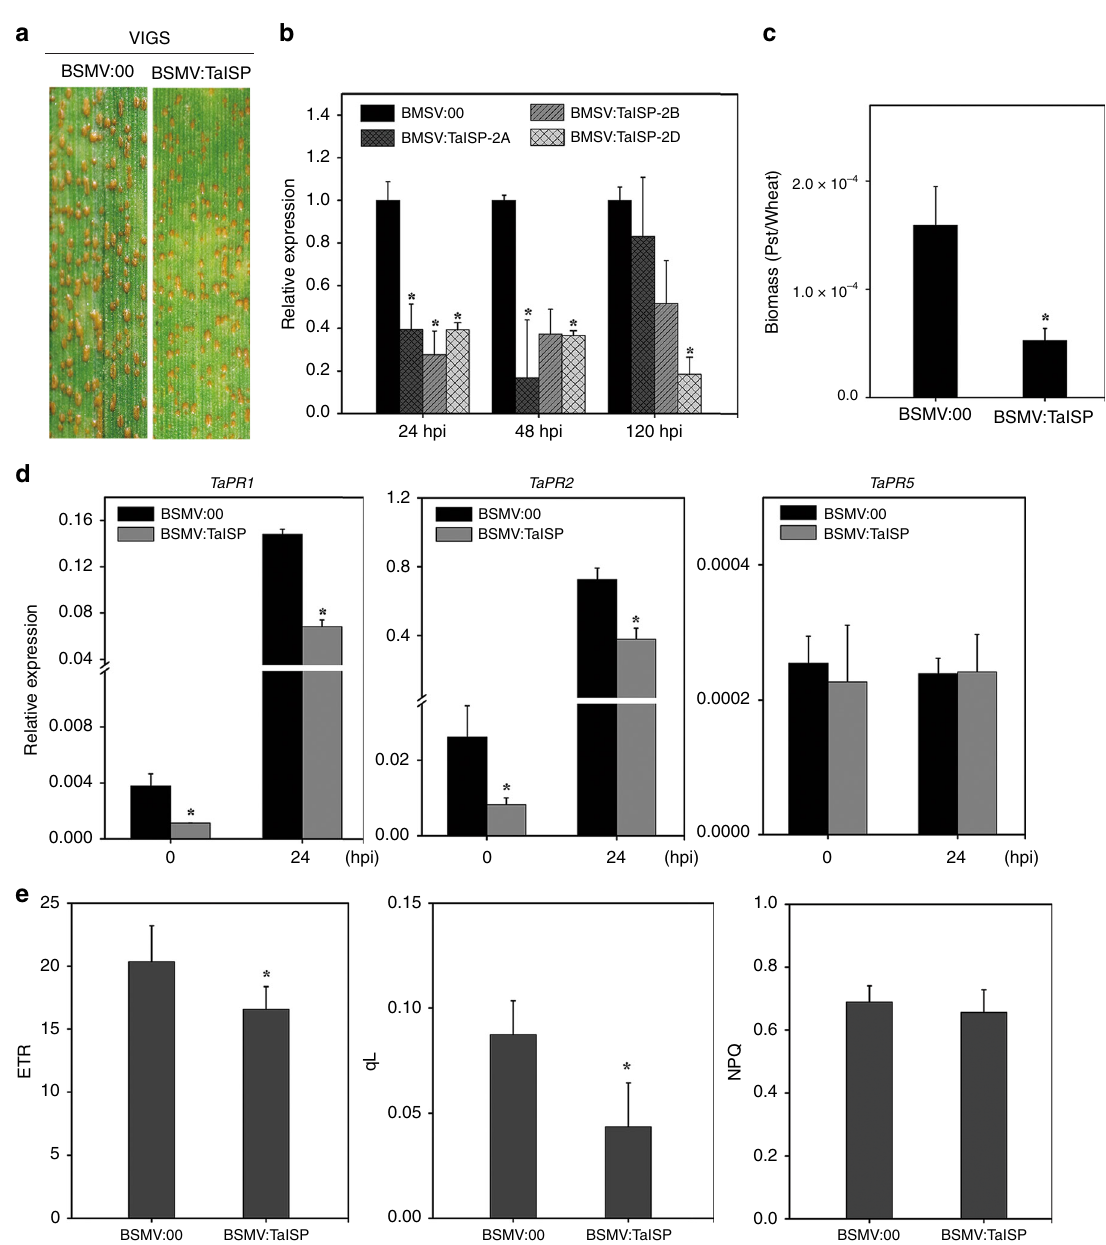
Fig. 6 Knocking down TaISP increases resistance to Pst and weakens photosynthesis. Seedlings of wheat cultivar Suwon 11 were inoculated with the empty BSMV:00 vector or recombinant BSMV:TaISP on the second leaves fi rst for 10 days and then infected with Pst CYR31 on the fourth leaves. a Pst uredinia on the fourth leaves were examined at 14 dpi. b The relative expression level of TaISP in leaves inoculated with Pst were assayed by qRT-PCR at 24, 48, and 120 hpi. c The biomass ratio ( Pst /wheat) was assayed with RNA isolated from the fourth leaves at 120 hpi. TaEF-1 α and PstEF-1 α were used to normalize the RNA level of wheat leaves and Pst , respectively. The experiments were repeated three times. An asterisk inidicates signi fi cant difference ( P < 0.05, Unpaired two-tailed Student ’ s t test). d Relative expression of the marked defense-related genes in the fourth leaves at 0 and 24 hpi. Transcript levels were quanti fi ed by qRT-PCR and normalized with TaEF-1 α . The mean and standard deviation were calculated from three independent biological replications. The asterisk indicates the signi fi cant difference compared with GFP treated plants ( P < 0.05, unpaired two-tailed Student ’ s t test). e The fourth whea t leaves ( n = 9) were collected at 10 days post inoculation with BSMV or BSMV:TaISP were assayed for photochemical quenching (qL), Non-Photochemical Quenching (NPQ), and electron transport rate (ETR). Mean values and standard deviation were assessed from three biological replications. An asterisk indicated the signi fi cant difference ( P < 0.05, unpaired two-tailed Student ’ s t expressed Pst_12806 in tobacco, the oxidized dichloro fl uorescein chloroplasts using the probe 2 ′ 7 ′ -dichlorodihydro fl uorescein (DCF) signal accumulated in the cytoplasmic membrane instead diacetate (H 2 DCF-DA) after bacterial infection of N . benthami- of chloroplasts (Fig. 7b). To better observe ROS accumulation, we ana 42 . Strong fl uorescence was observed mainly in chloroplasts directly imaged samples from the lower epidermis. Compared and cell membranes in the leaves in fi ltrated with Ethan:DsRed, with the control plants in fi ltrated with Ethan:DsRed, signals con fi rming that the accumulation of ROS in response to bacterial rarely appeared in chloroplasts on leaves in fi ltrated with Ethan: infection is chloroplast derived (Fig. 7b). When we transiently